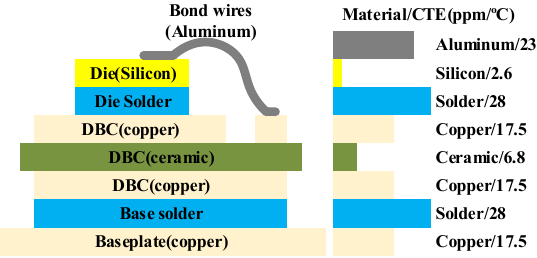
Figure 1. Structure of wire ‐ bonded IGBT module.